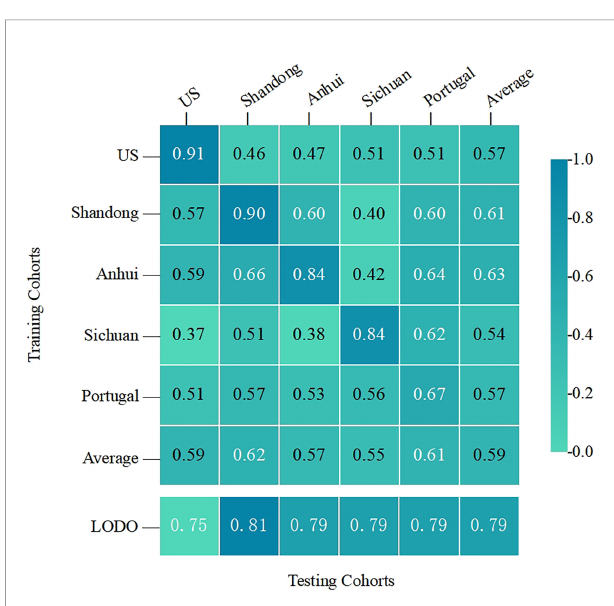
FIGURE 5 | The cross-prediction matrix thoroughly showed the AUC values of the fi ve studies themselves and between them for the prediction of T2DM. The values on the diagonal were the results of the cross-cohort validation within each study. The non-diagonal AUC values were obtained by training the classi fi er on the study in each row and tested on the study in the corresponding